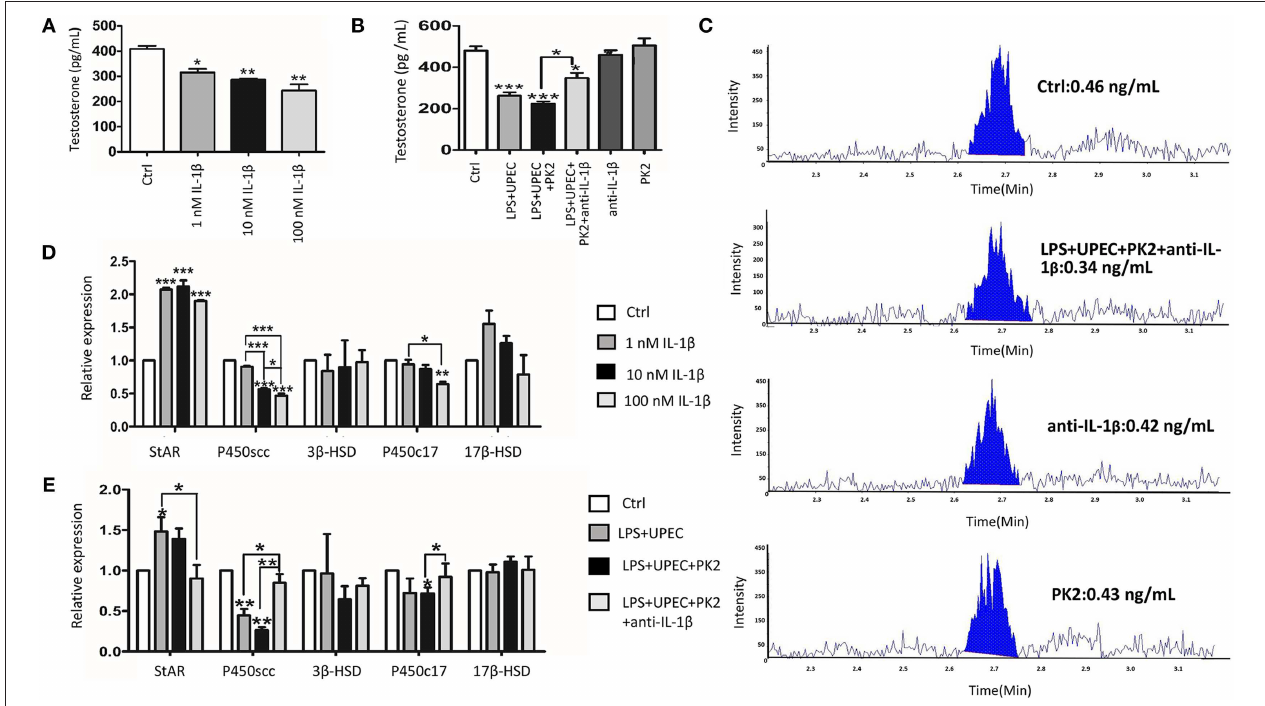
FIGURE 6 | IL-1 β inhibits testosterone production by repressing the expression of P450scc and P450c17. (A) Testosterone produced by Leydig cells under the stimulation of various concentrations of IL-1 β (1nM, 10nM, and 100nM) for 24h. (B) The conditioned medium from TM without treatment (control) or with indicated treatments was collected, filtered, and then co-cultured with Leydig cells for 24h. (C) The testosterone production by Leydig cells was detected by LC-MS. The content of IL-1 β in the supernatants of some treatment groups (100nM IL-1 β , LPS + UPEC, LPS + UPEC + 10nM PK2) is lower than the limit of detection, the corresponding results are not shown. (D) The mRNA expression of StAR, P450scc, P450c17, 3 β -HSD, and 17 β -HSD in Leydig cells treated with various concentrations of IL1 β (1nM, 10nM, and 100nM) for 24h was detected by PCR. (E) The mRNA expression of StAR, P450scc, P450c17, 3 β -HSD, and 17 β -HSD in Leydig cells treated with TM-condition medium for 24h was detected by PCR. Ctrl, control. * P < 0.05, ** P < 0.01, *** P < 0.001 (one-way